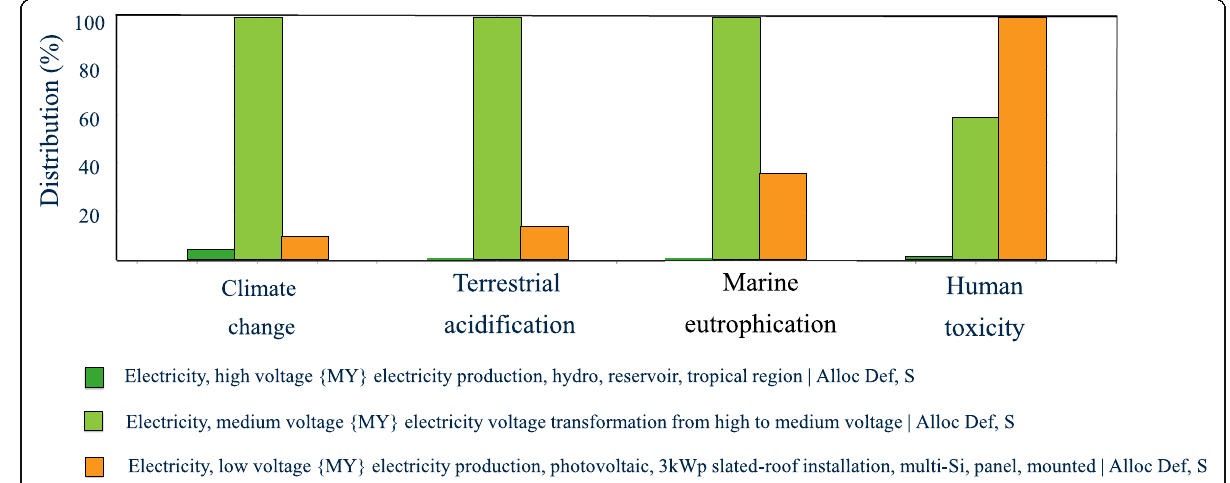
Fig. 5 Contribution of alternatives of electricity production towards life cycle impact